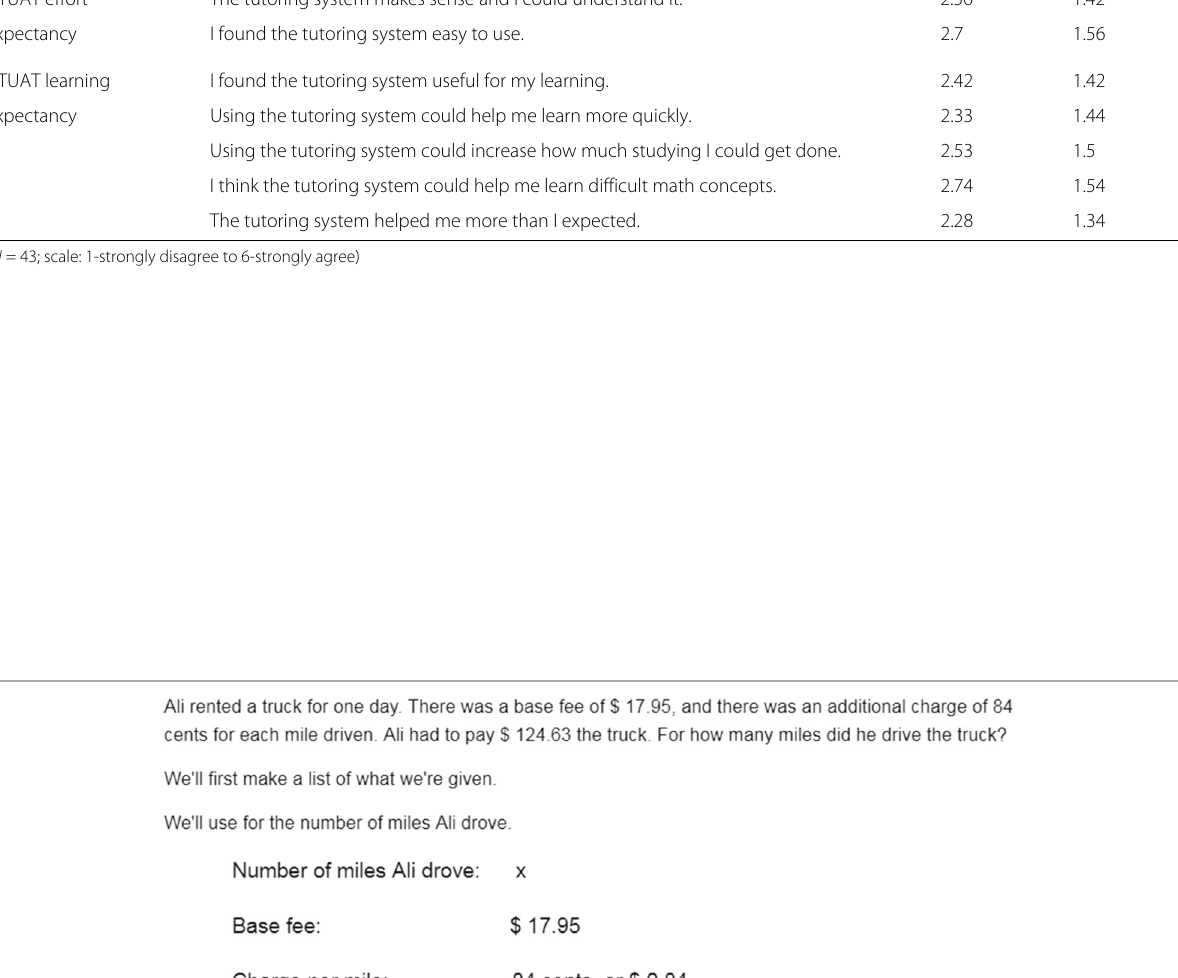
Table 5 Post-survey item means and standard deviations ( Continued ) UTUAT effort